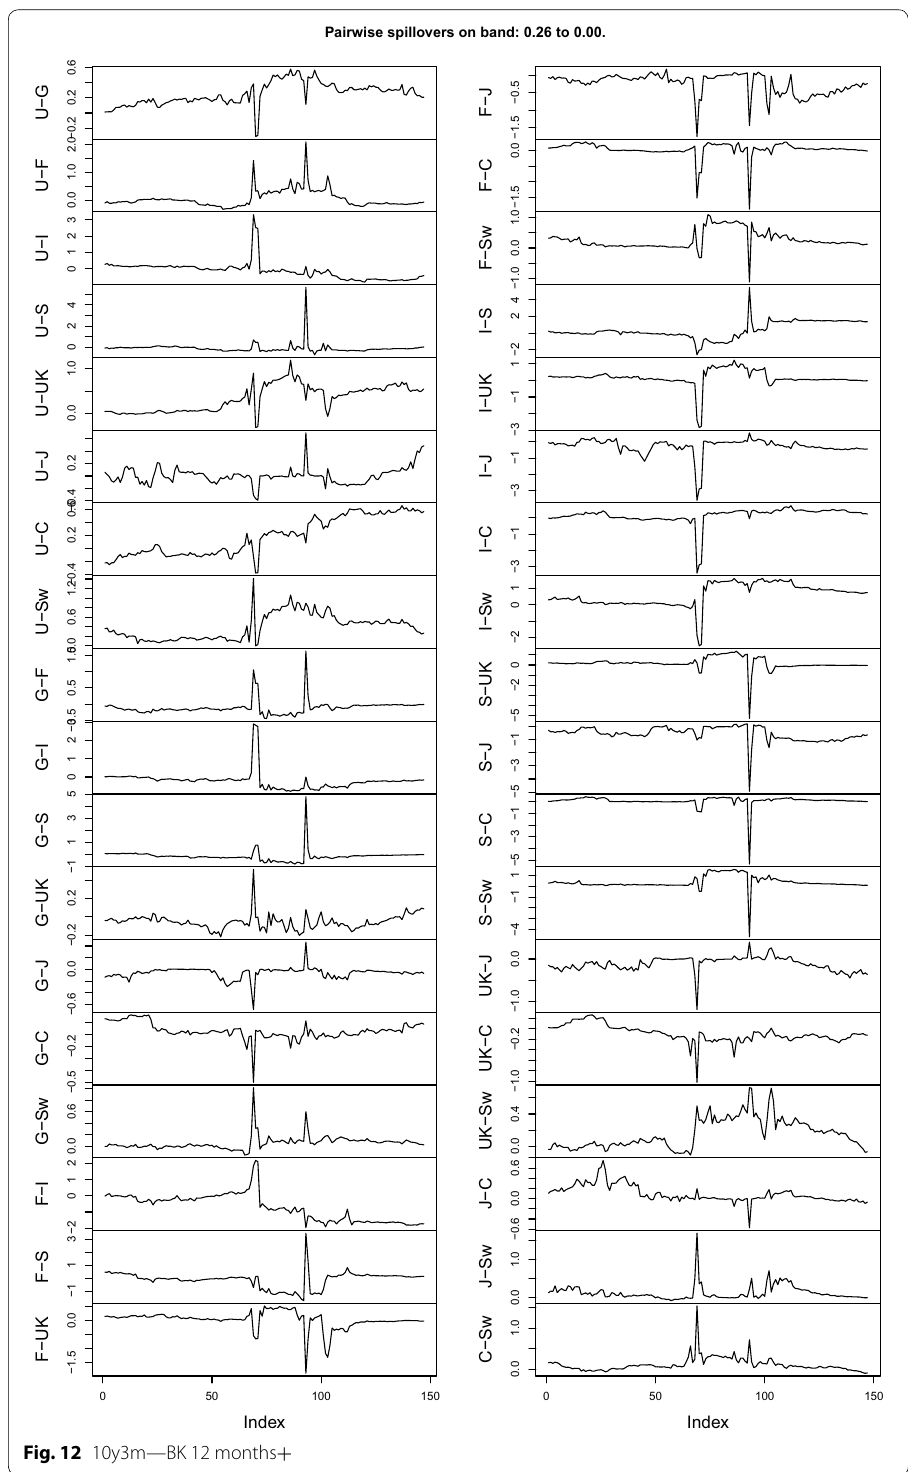
Fig. 12 10y3m—BK 12 months